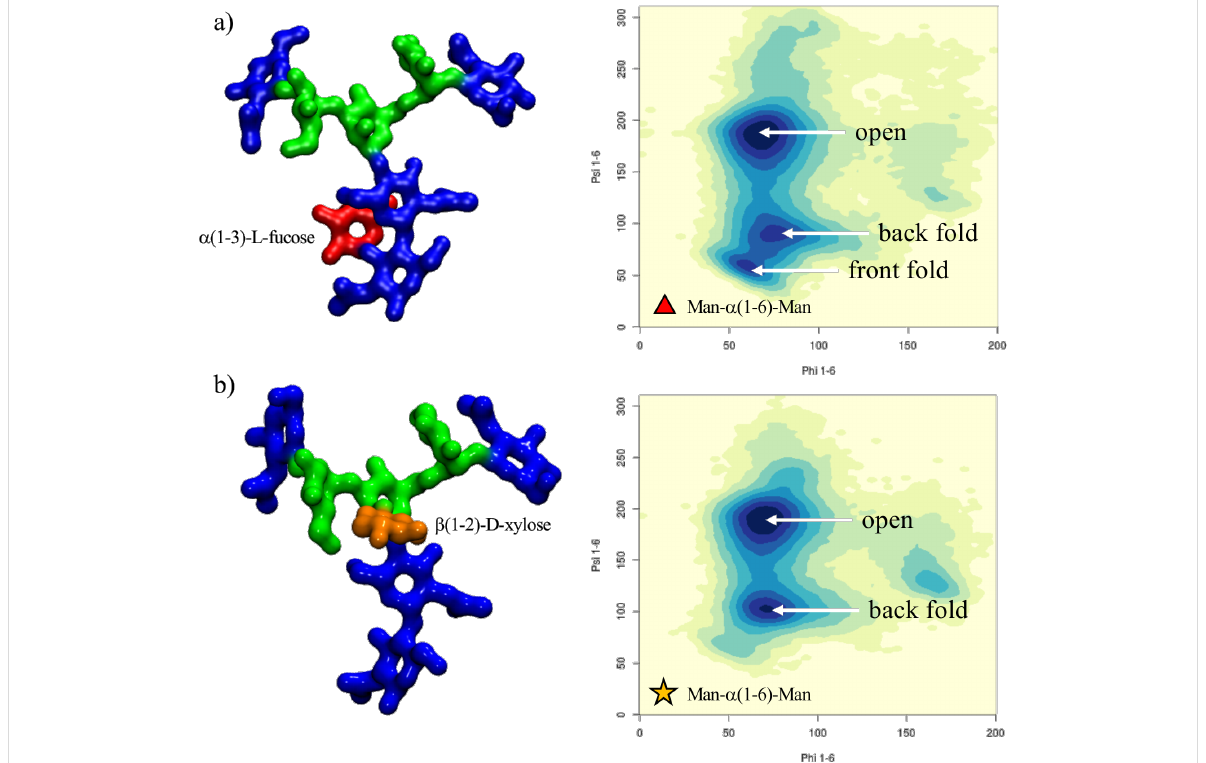
Figure 2: A representative structure of the non-galactosylated N-glycan with α (1-3)-linked core fucose ( ngf ) is shown in panel a), with on the right- hand side the corresponding heat map showing the conformations accessible to the (1-6) arm in terms of the phi/psi torsion angles. A representative structure of the non-galactosylated N-glycan with β (1-2)-linked xylose ( ngx ) is shown in panel b), with on the right-hand side a heat map showing the conformations accessible to the (1-6) arm in terms of the phi/psi torsion angles. The N-glycans structures are shown with the (1-3) and (1-6) arms on the left and on the right, respectively. The monosaccharides colouring follows the SFNG nomenclature. The structure rendering was done with VMD (https://www.ks.uiuc.edu/Research/vmd/) and the graphical statistical analysis with RStudio